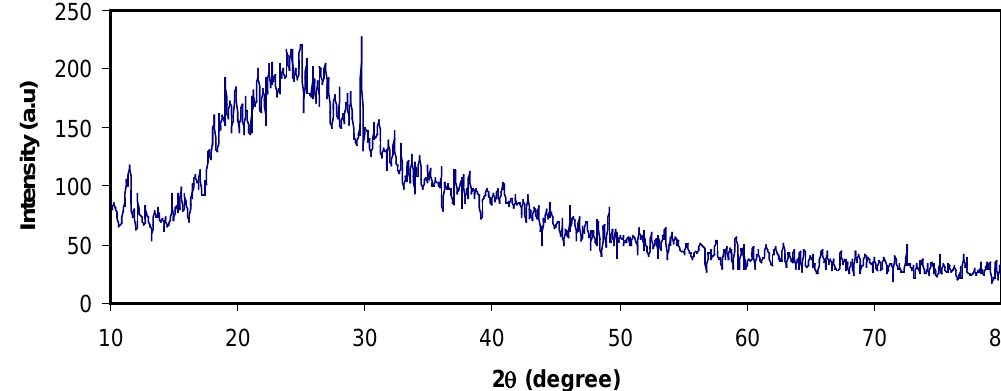
Figure 1. XRD spectra for the un-plasticized of the PVA: CS: 40%NH 4 SCN system at room temperature.